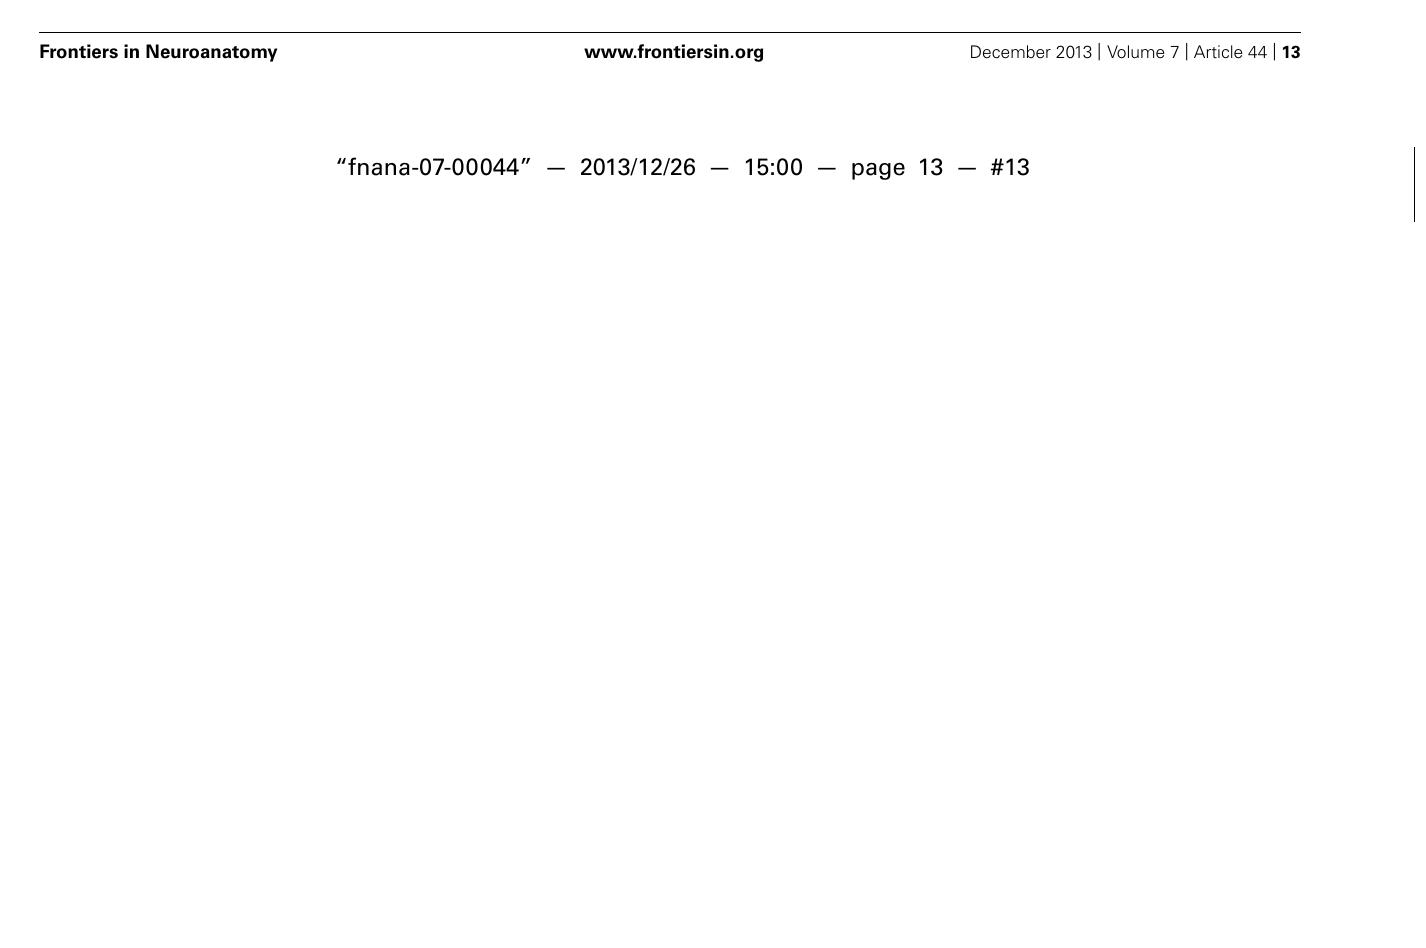
(F) all exhibited evident glial scar formation, while reactive gliosis markedly decreased in C16 − (G) and C16 + CNTF-treated (H) EAE rats. (I-L) GFAP expression was visibly reduced at week 2 post-immunization following CNTF, C16, and C16 + CNTF treatment, but not at week 8 post-immunization following CNTF treatment, as shown byWestern blotting. (M,N) : a P < 0.05 versus normal control; b P < 0.05 versus vehicle-treated EAE rats; c P < 0.05 versus C16-treated EAE rats; d P < 0.05 versus CNTF-treated EAE